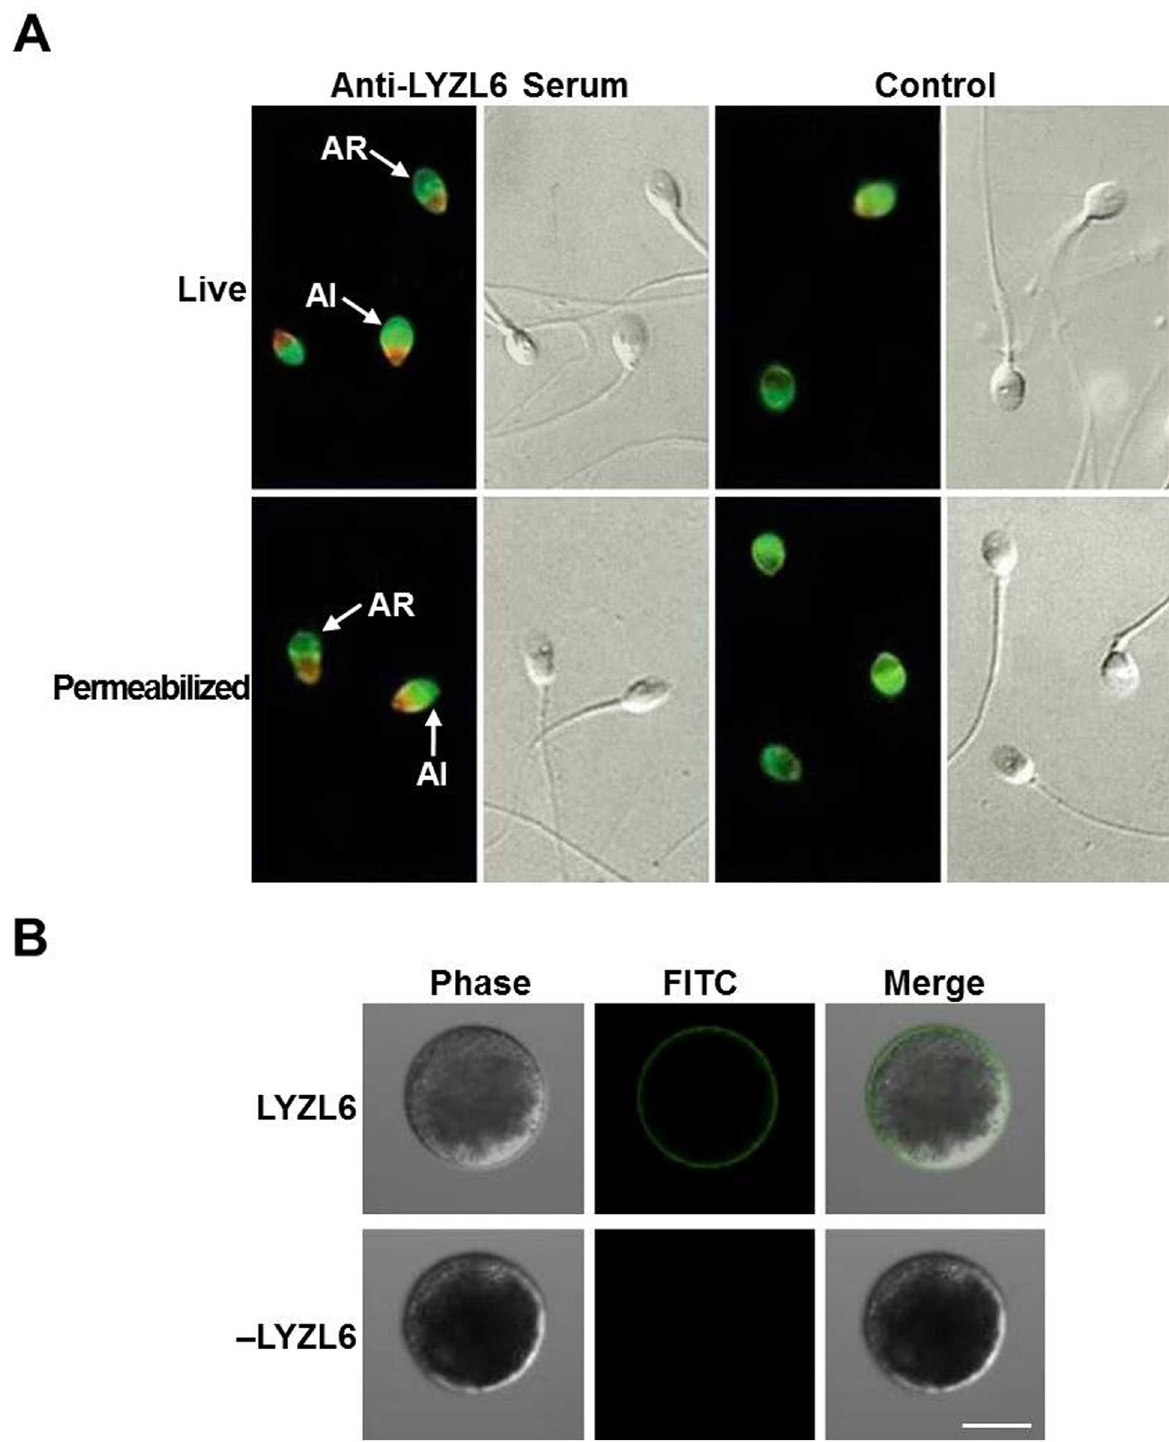
Fig 7. Immunofluorescencestaining of LYZL6 in spermatozoa and rLYZL6 bound to zona-free hamster eggs. A) Live and permeabilizedspermatozoawere incubatedwith the anti-LYZL6 serum or preimmune rabbit serum, followedby a rhodamine- conjugated goat anti-rabbitsecondary antibody.A band-likepattern (red) was detected on the postacrosomal regionfor LYZL6 in acrosome-reacted (AR) and in acrosomeintact (AI) cells. No similar stainingof LYZL6 was seen in the control cells. The FITC-PSA stainingwas used to distinguish membranechangesin spermatozoadue to acrosome reaction. B) The eggs were incubatedwith rLYZL6 (upper panels) or without rLYZL6 (lower panels)and probedwith the anti-LYZL6serum. Scale bar = 50 μ m.